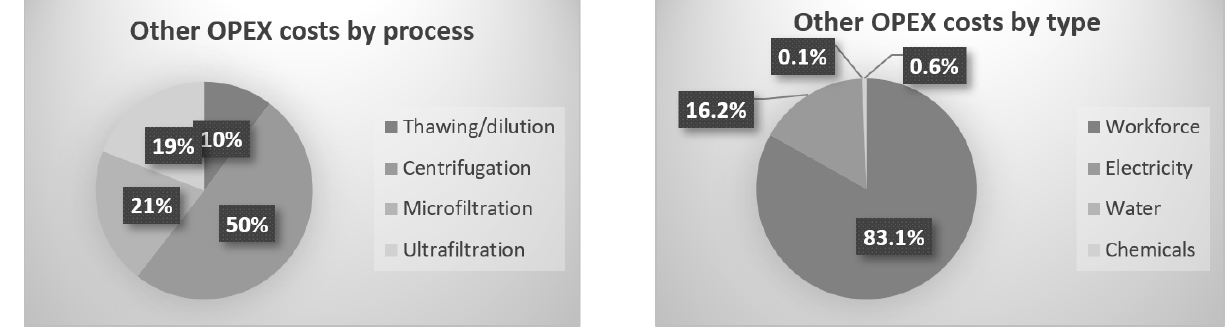
Figure 6. Repartition of OPEX costs as a function of the process unit and